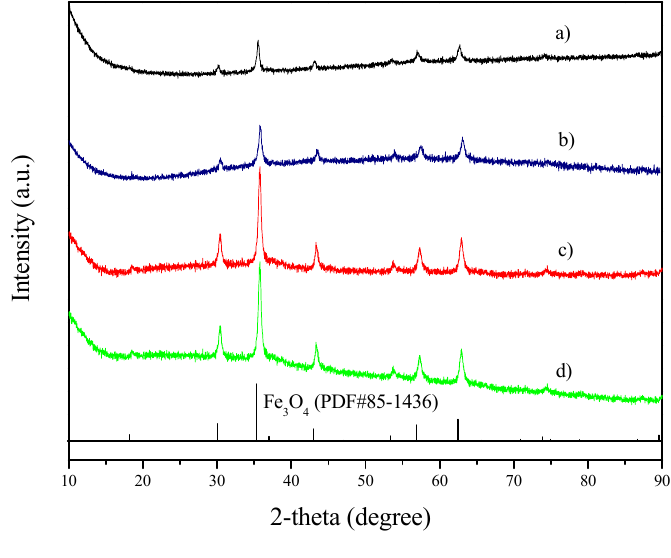
/Fe O calcined at 500 °C to remove the soft template; ( d ) Au/m-SiO 2 3 4